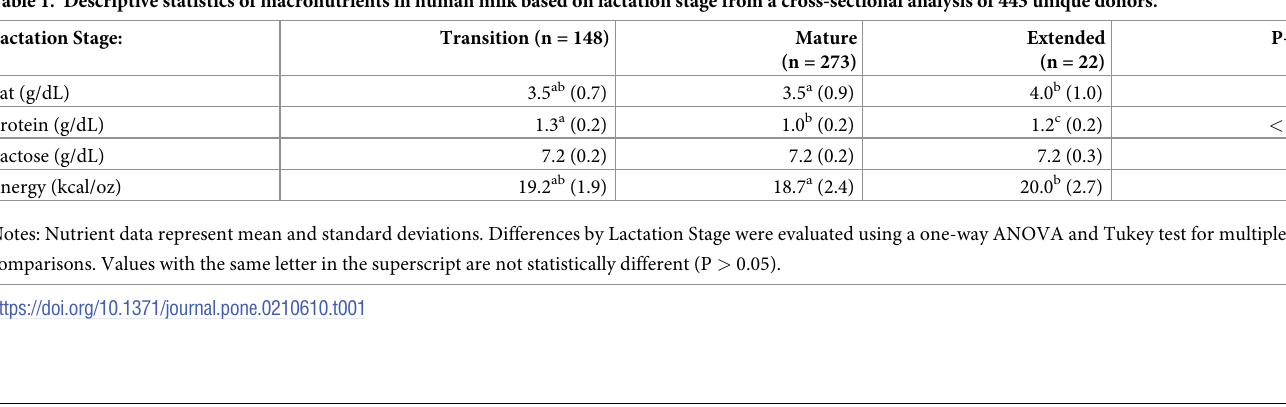
Table 1. Descriptive statistics of macronutrients in human milk based on lactation stage from a cross-sectional analysis of 443 unique donors. Lactation Stage: